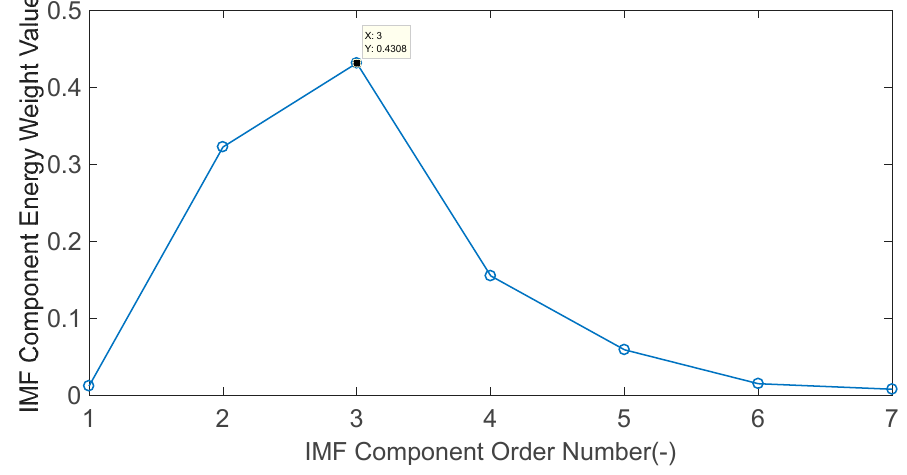
Figure 17. Each IMF component energy weight value of the engine block vibration signal under a weak knock condition at 5200